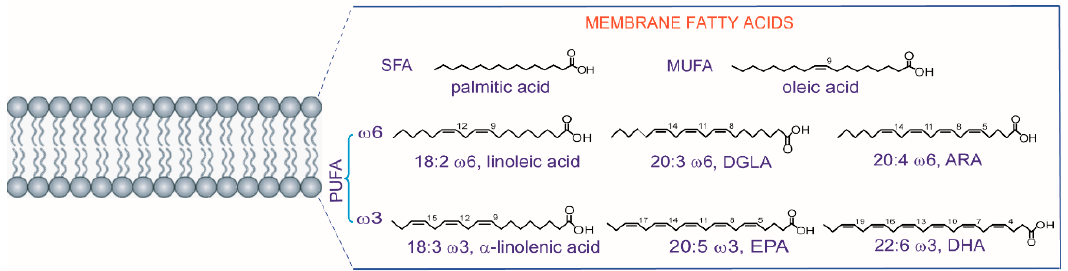
Figure 1. The fatty acid constituents of phospholipids: saturated fatty acids (SFA), monounsaturated fatty acids (MUFA) and polyunsaturated fatty acids (PUFA) are shown with their most present structures in eukaryotic membranes.